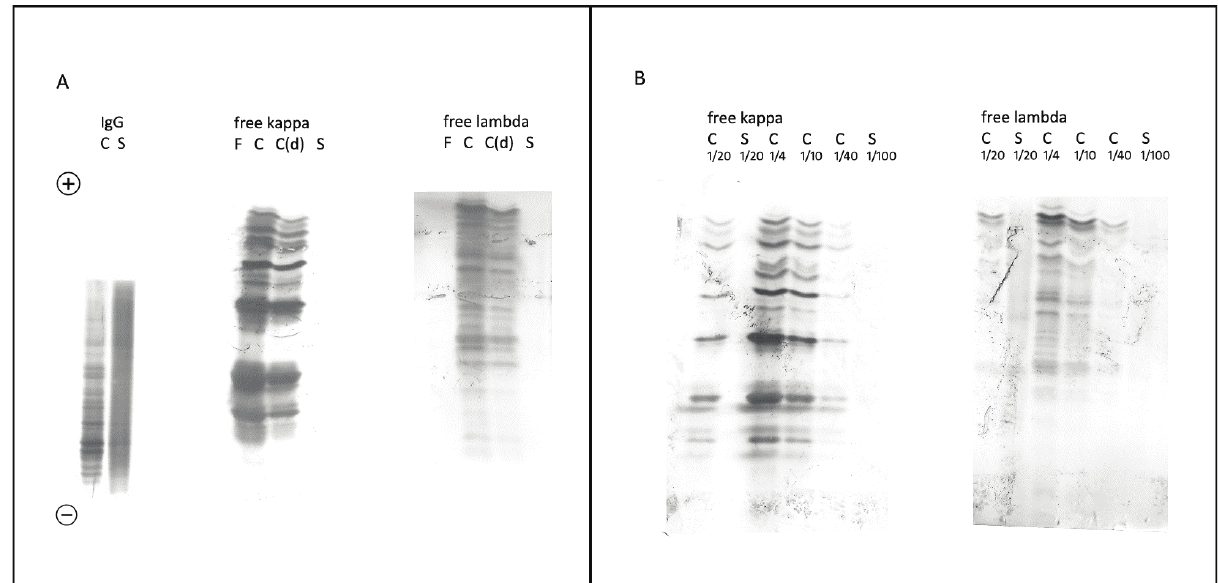
Fig. 1. Pronounced intrathecal IgG and fLC synthesis in the case of malignant meningeal infiltration. C, cerebrospinal fluid; S, serum; F, Flebogamma (intravenous IgG preparation – negative control); (d), diluted 1/4. (A) CSF- restricted oligoclonal IgG, free κ and free λ bands. For fLC analysis, CSF sample was examined neat as well as diluted 1/4. (B) Dilution experiments showing CSF-restricted o-fLC bands even when CSF and serum were equally diluted (1/20). Higher concentration of CSF fLC than in serum can be assumed. Indeed, using Freelite kit on the SPA Analyzer (The Binding Site, Birmingham, United Kingdom), we measured CSF free κ and free λ 80.5 mg/L and 32.2 mg/L, respectively, whereas serum free κ and free λ concentrations were 14.5 mg/L and 12.1 mg/L,